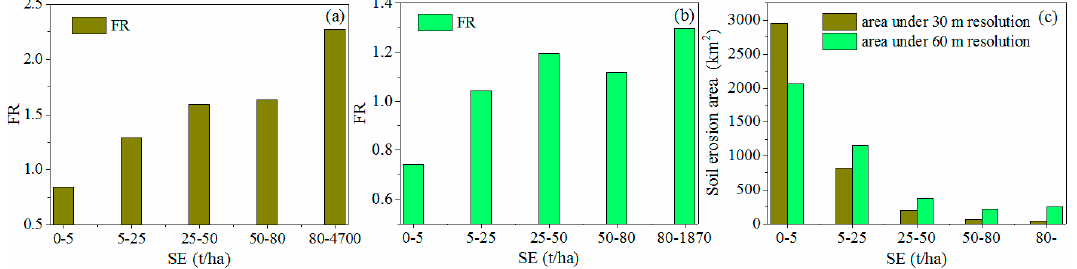
Figure 7. FR values between SE and landslides with resolutions of 30 m ( a ), 60 m ( b ) and areas distribution ( c ) 5.2. Importance Analysis of Soil Erosion in LSP.